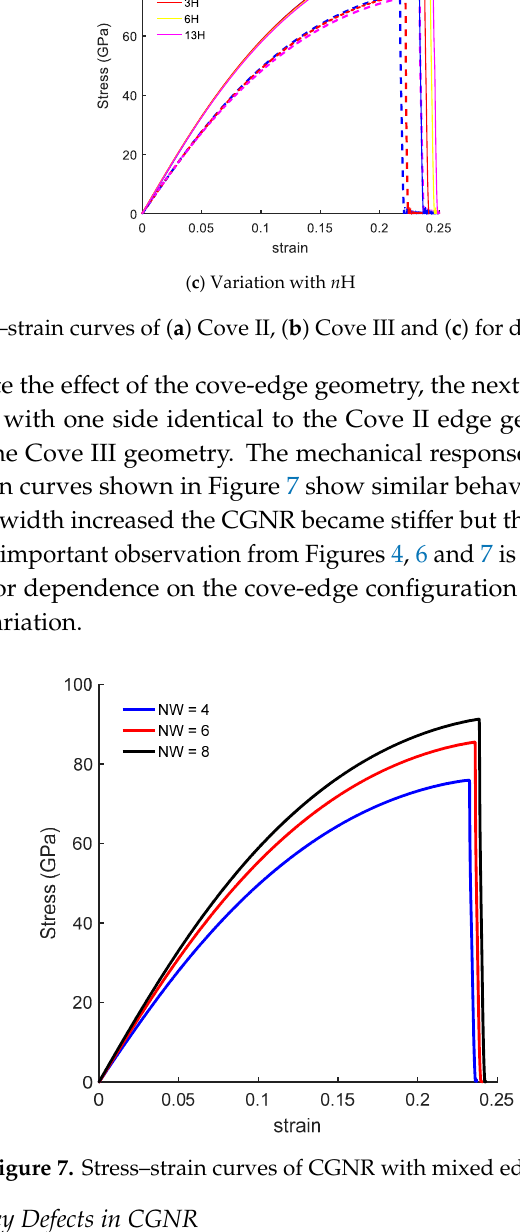
Figure 7. Stress–strain curves of CGNR with mixed edges.